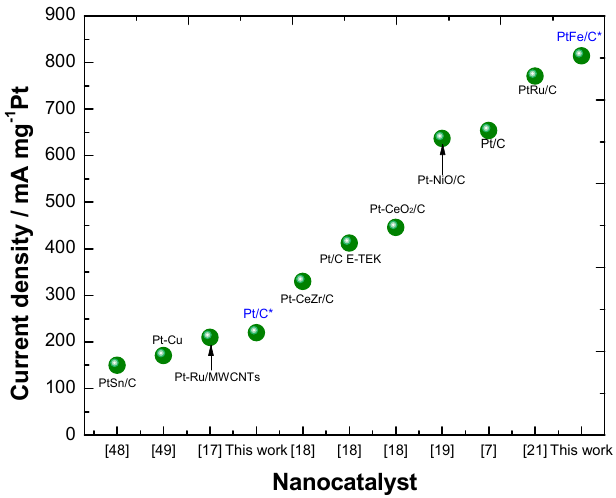
Figure 9. Analysis of peak current densities of various nanocatalysts found in the literature for the electro-oxidation of 1 M ethanol. Only materials that were normalized by mass activity (mA·mg − 1 Pt) were considered for comparison purposes.